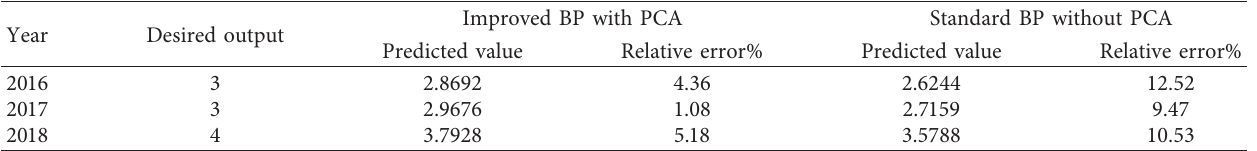
Figure 4: Improved BP neural network training process with PCA. Table 8: Prediction